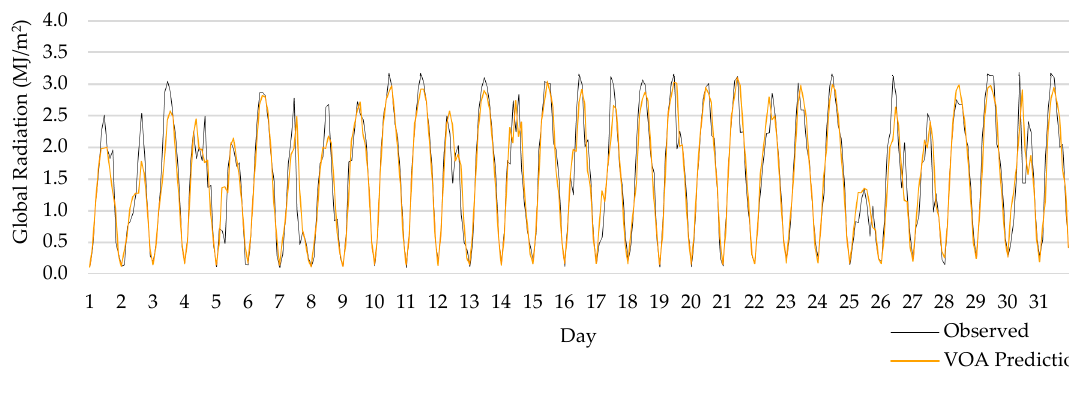
Figure 8. Histogram of the absolute error for all ML algorithms. ( a ) Summer. ( b ) Winter. Figure 9 shows the solar radiation observed, forecast and the residuals obtained with the VOA algorithm during the months of winter and summer seasons, respectively. The forecasting error is larger in summer than in winter.